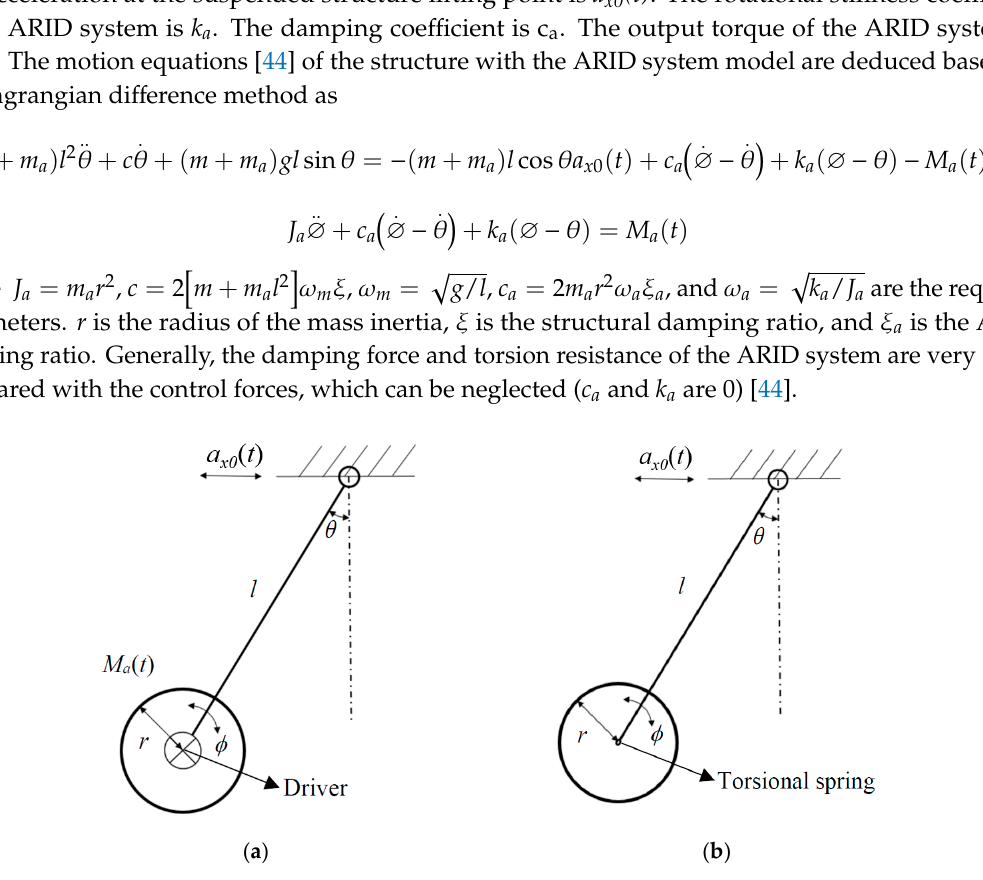
Figure 1. The simplified analytical model of the suspended structure with the control system: ( a ) The structure with the Active Rotary Inertia Driver (ARID) system; ( b ) the structure with the Tuned Rotary Inertia Damper (TRID) system.